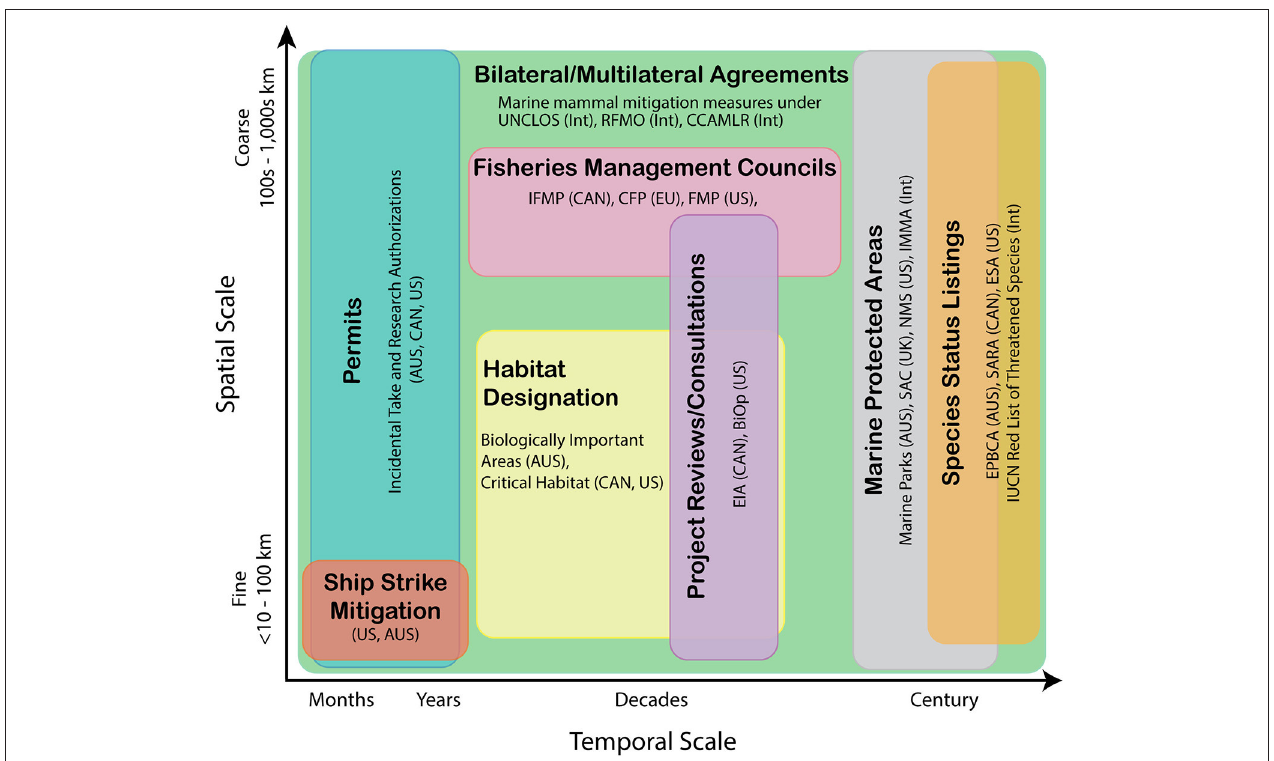
FIGURE 1 | Various examples of national and international management activities mapped conceptually along generalized temporal and spatial (both granularity and extent) scales. Management and research objectives on appropriate spatial/temporal scales will dictate model type selection and data requirements. AUS, Australia; BiOp, Biological Opinions; CFP, Common Fisheries Policy; CCAMLR, Commission for the Conservation of Antarctic Marine Living Resources; ESA, Endangered Species Act; EIA, Environmental Impact Assessments; EPBCA, Environment Protection and Biodiversity Conservation Act; EU, European Union; FMP, Fishery Management Plans; IFMP, Integrated Fisheries Management Plans; IMMA, Important Marine Mammal Areas; Int, International; IUCN, International Union for Conservation of Nature; NMS, National Marine Sanctuaries; RFMO, Regional Fishery Management Organizations; SAC, Special Areas of Conservation; SARA, Species at Risk Act; UK, United Kingdom; UNCLOS, United Nations Convention of the Law of the